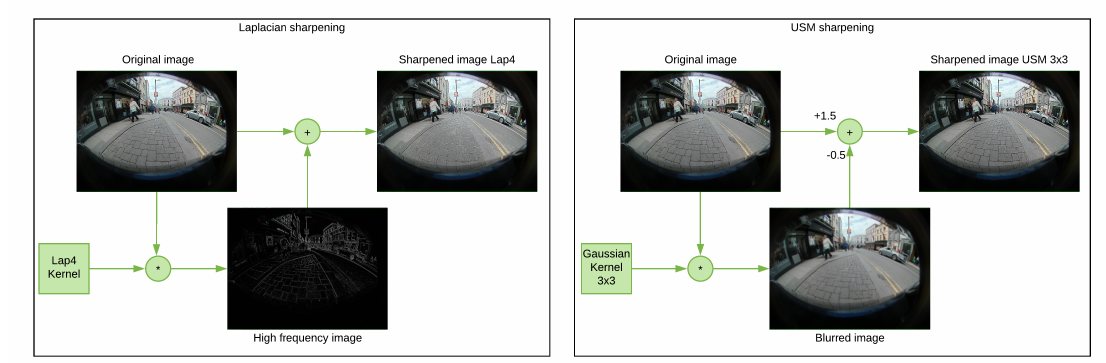
Figure 9. Sharpening methods | Left: using Laplacian filters/Right: using USM.